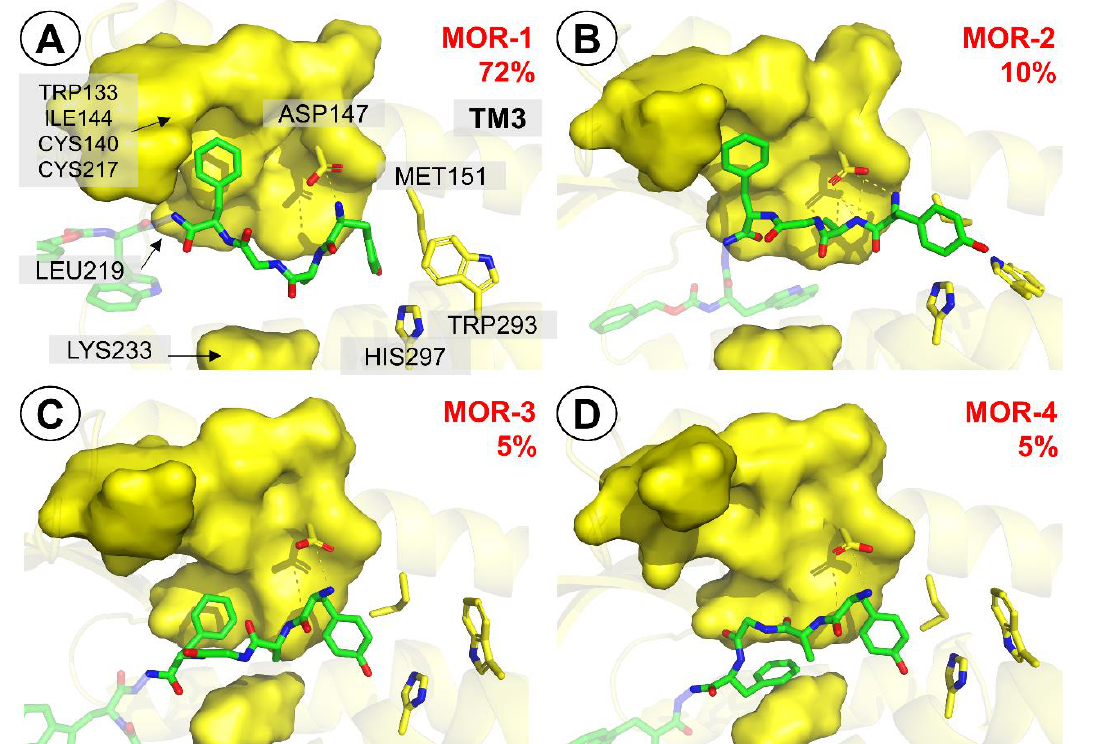
Figure 6. Representative structures for the clusters from MD simulations of AA3266 in the µOR binding site. Focus on the opioid part. ( A ) MOR-1 cluster, ( B ) MOR-2 cluster, ( C ) MOR-3 cluster, ( D ) MOR-4 cluster. Only a few receptor (yellow) side chains and helices are shown for clarity. The surface covers a few side chains from TM3, ECL2, ECL3 and TM5 important for binding. The red number is the cluster population.